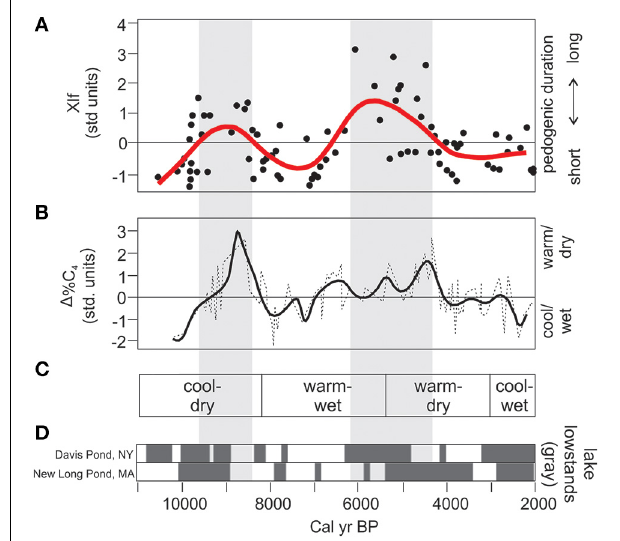
FIGURE 10 | X lf time series and climate data for northeastern USA study area. (A) Standardized X lf for T2 alluvial soils along the Delaware River Valley (see Figure 1 for profile locations; Supplementary Table 5 for X lf data). Vertical gray bars denote enhanced X lf intervals suggesting prolonged pedogenesis. (B) Standardized variation in the %C 4 plants ( (cid:2) %C 4 ) for the Delaware River valley (Stinchcomb et al., 2013). (C) Documented climate intervals for northeastern USA (Shuman et al., 2004). (D) Documented lake lowstands for Davis Pond, NY (Newby et al., 2011) and New Long Pond, MA (Newby et al., 2009; Shuman et al., 2009). The vertical gray bars denote intervals of enhanced X lf that are inferred here to reflect times of prolonged alluvial soil formation along the